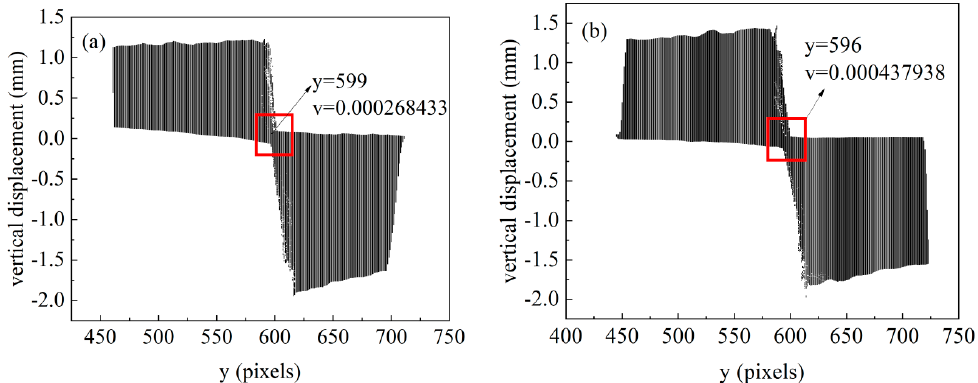
Figure 3. Variation in vertical displacement with y‑coordinate for specimens B1 and W1 crack areas: ( a ) specimen B1 ( a = 25.02 mm); ( b ) specimen W1 ( a = 24.48 mm).